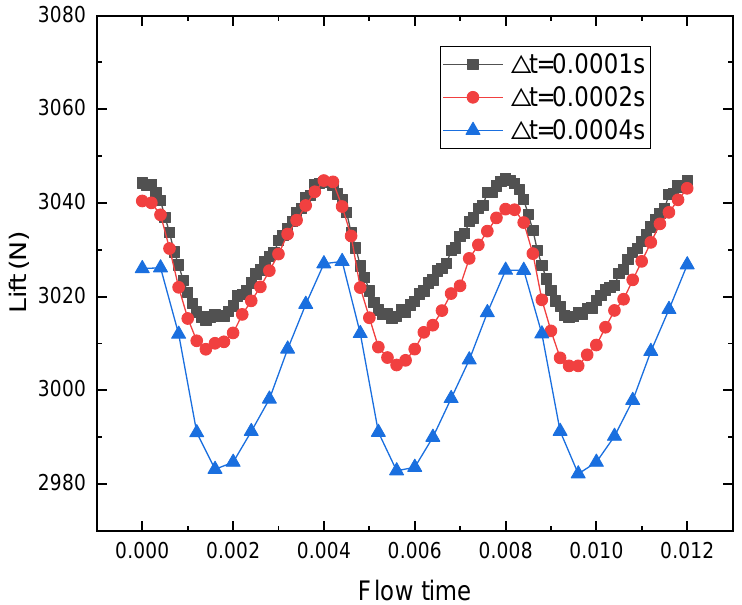
Figure 9. Lift history of coaxial propellers versus time steps.